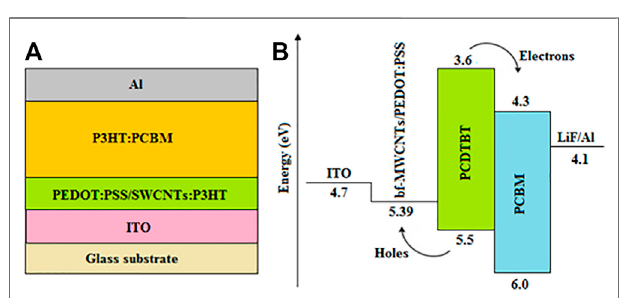
FIGURE8|(A) SchematicdiagramofthePEDOT:PSS/SWCNTs:P3HT- based BHJ-OSC, and (B) energy level diagram of the bf-MWCNTs/PEDOT: PSS HTL-based OSC with the poly [N-9 ′ -heptadecanyl-2,7-carbazole-alt- 5,5-(4 ′ ,7 ′ -di-2-thienyl-2 ′ ,1 ′ ,3 ′ -benzothiadiazole)] (PCDTBT):PCBM active layer blend.